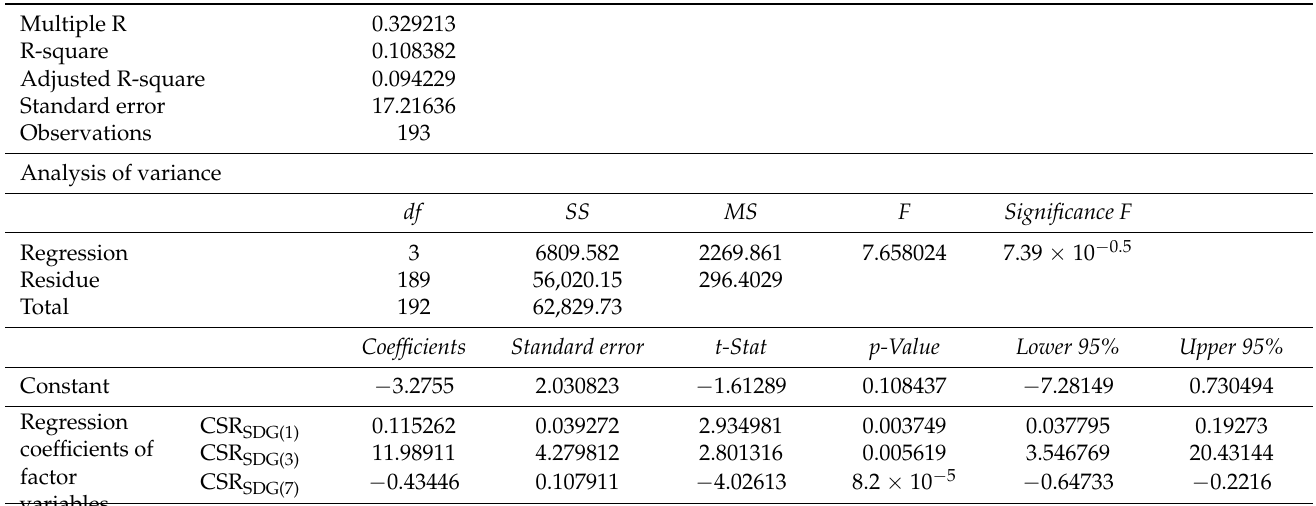
Table 14. Regression statistics for the factor variables that are connected to profit at the significance level of